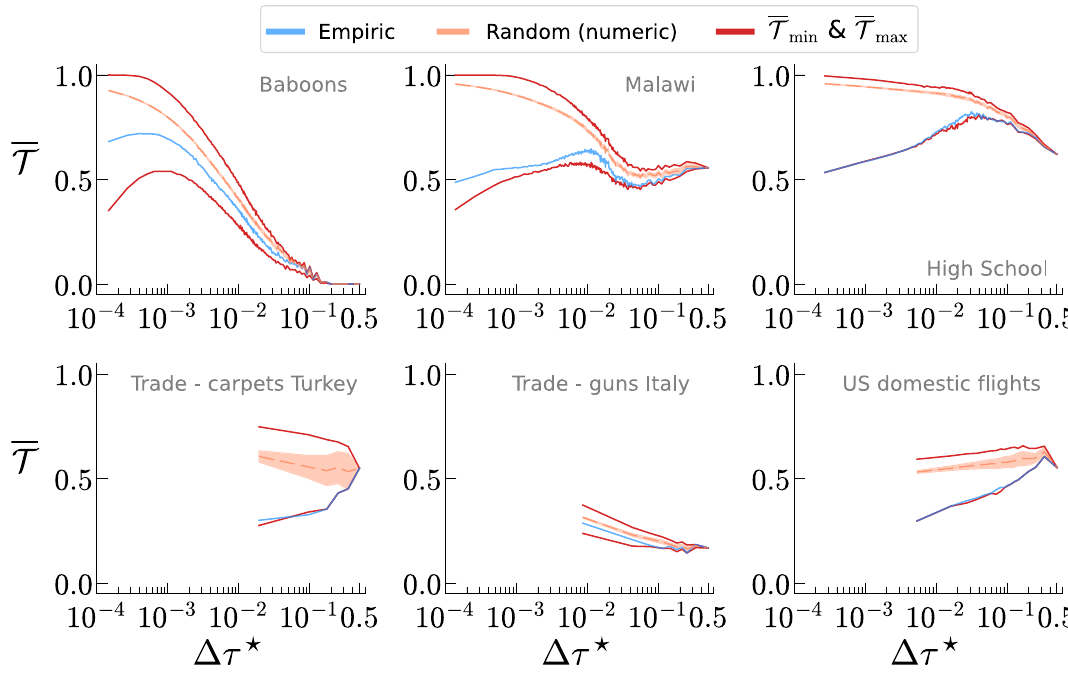
Figure 3. Effects of the coarse graining (i.e., time resolution) on the temporality. We display the values of the empiric temporality, T , of the mean and standard deviation of the distribution of temporality of randomly shuffled sequences, T rand , and of the maximum and minimum values ( T max , T min ) as a function of the rescaled time resolution �τ ⋆ . Each panel refers to a distinct